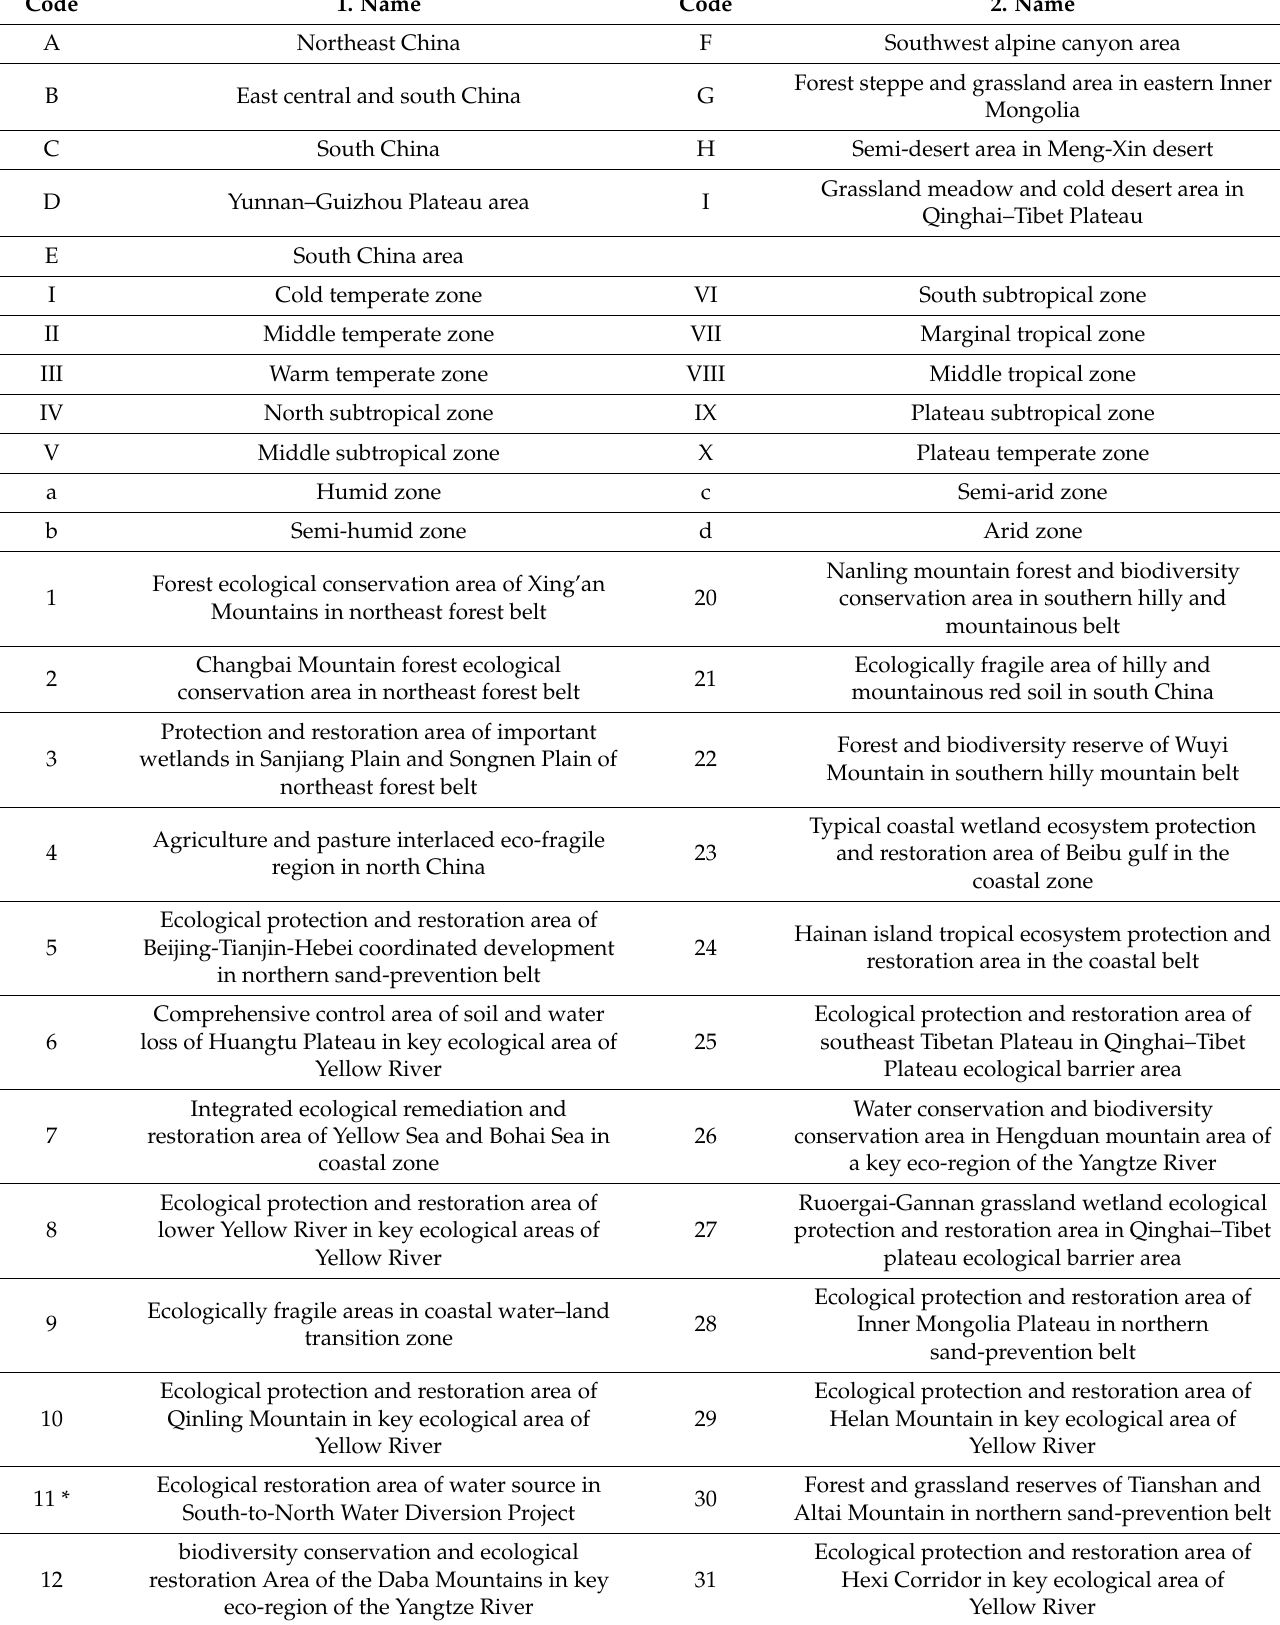
Table 3. The meaning of codes in the names of ecological function zones of